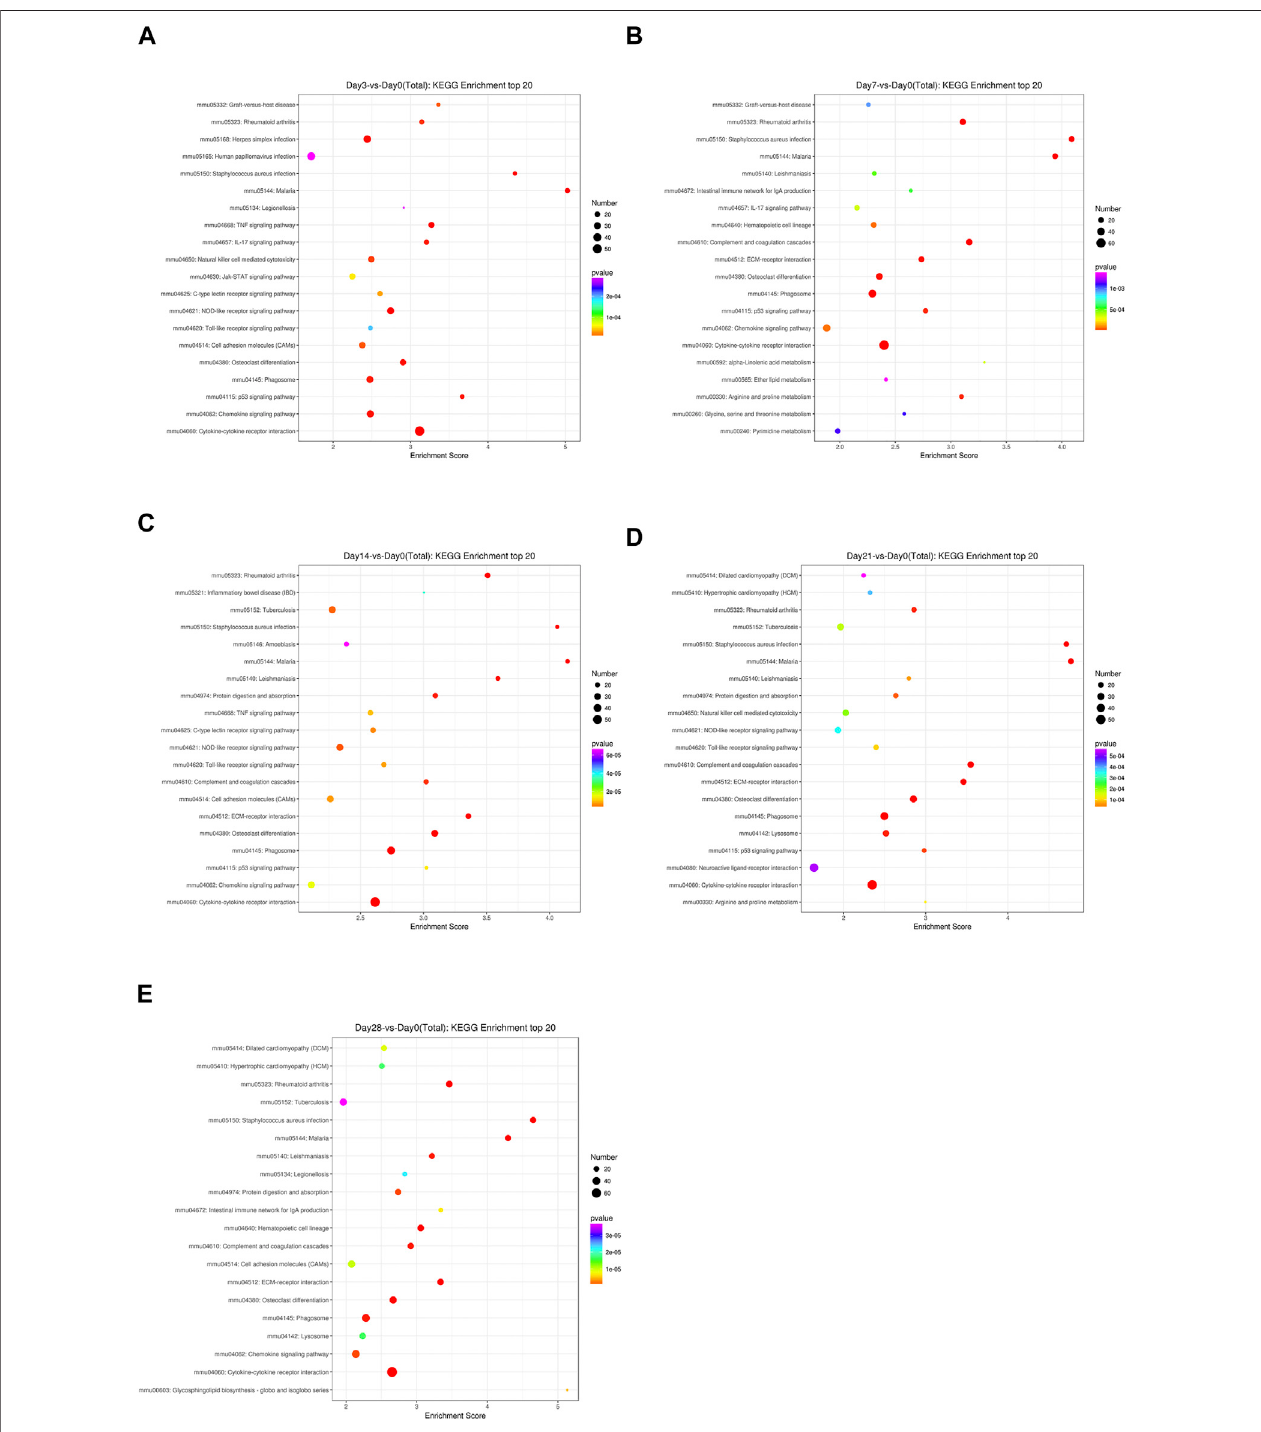
FIGURE 3 | KEGG signaling pathways of differentially expressed genes at different stages in bleomycin-induced fi brosis models. The top 20 KEGG pathways of differentially expressed genes between the group of mice treated with bleomycin and the control are shown. (A) At day 3 post-bleomycin vs. the control. (B) At day 7post-bleomycinvs.thecontrol. (C) Atday14post-bleomycinvs.thecontrol. (D) Atday21post-bleomycinvs.thecontrol. (E) Atday28post-bleomycinvs.thecontrol. (A – E) X-axis indicates the enrichment scores. The size of the bubble indicates the number of differentially expressed genes enriched in the indicated pathway.